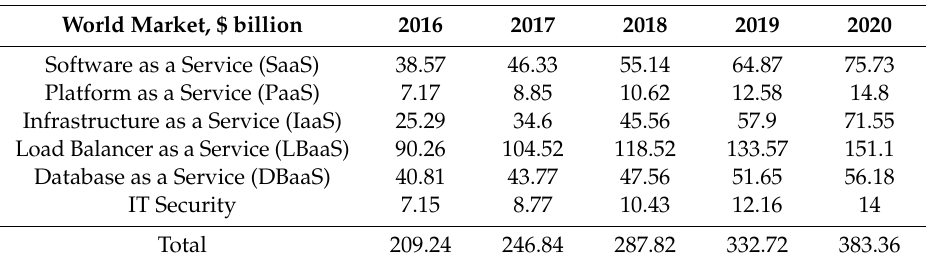
Table 1. Gartner analytics of growth trend for main cloud